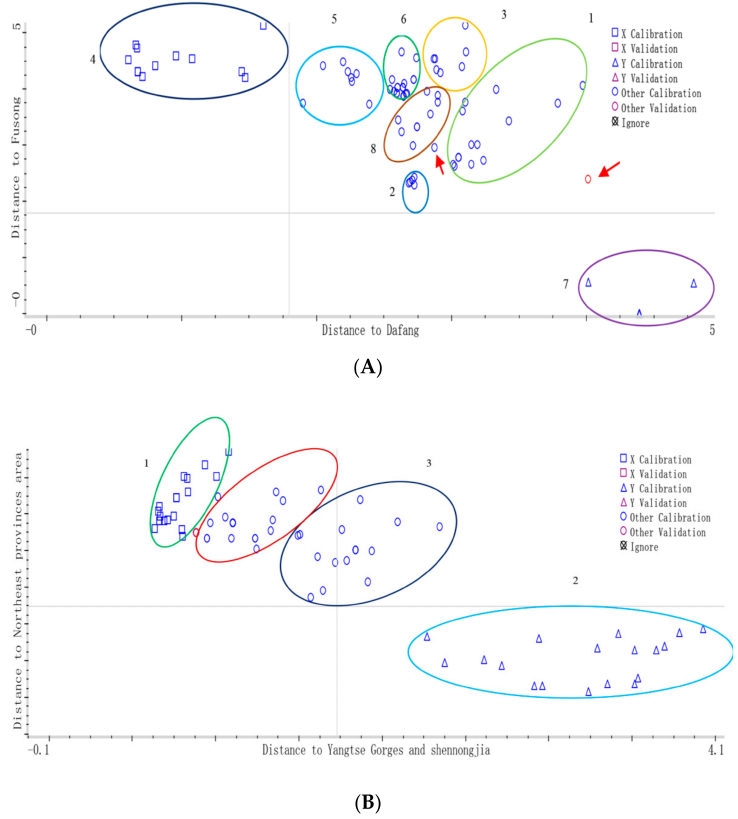
Figure 6. ( A ) DA scores plot of G. elata samples marked by different geographical origins from eight differentcities: 1. Yichang (Hubei) 2. Hanzhong (Shanxi) 3. Zhaotong (Yunnan) 4. Dafang (Guizhou) 5. Dabieshan (Anhui) 6. Funiushan (Henan) 7 Fusong (Jilin) 8. Dandong (Liaoning). The red arrows referred to sample that misclassified in calibration sets; ( B ) DA scores plot of G. elata samples marked by different geographical origins. From four main-cultivated areas: 1. Yangtse Gorges and Shennongjia area; 2. Northeast provinces area; 3. Dabieshan area; 4. Southwest provinces